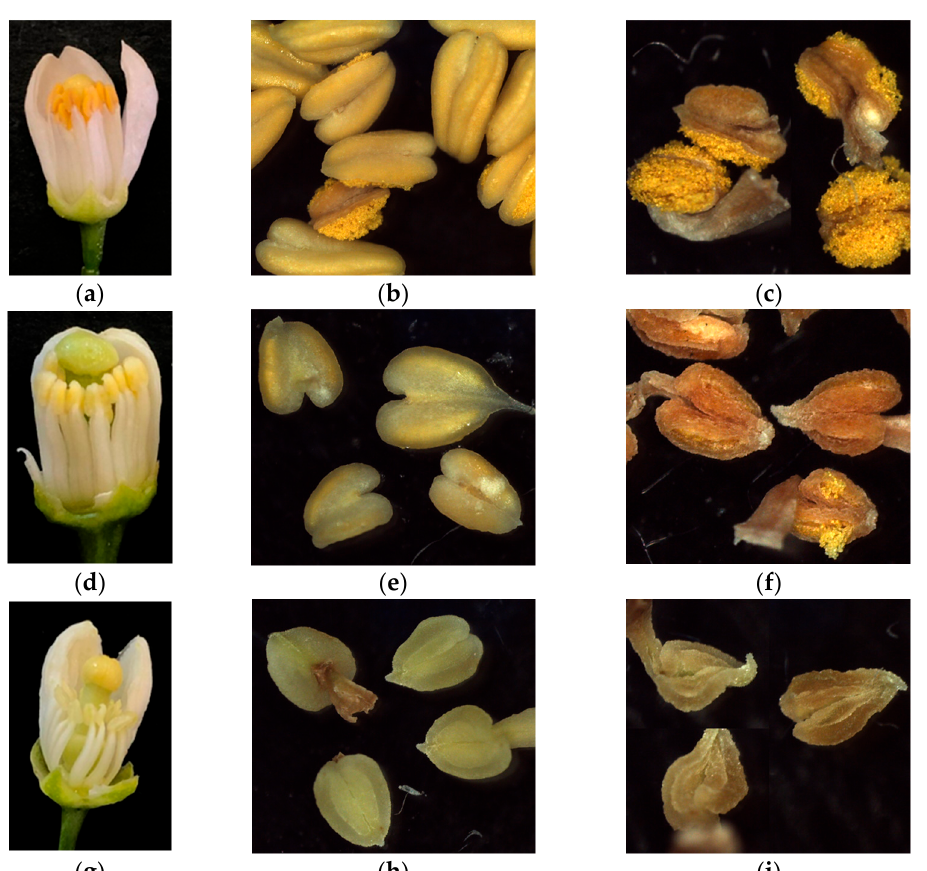
Figure 4. Di ff erent types of fl ower phenotypes observed in the segregation progeny recovered from Figure 4. Different types of flower phenotypes observed in the segregation progeny recovered from the cross between ‘Kiyomi’ and ‘Murco tt ’. ( a – c ) High number; ( d – f ) moderate-to-low; ( g – i ) very the cross between ‘Kiyomi’ and ‘Murcott’. ( a – c ) High number; ( d – f ) moderate-to-low; ( g – i ) very low-to-null pollen grain quantity. This quanti fi cation was observed in fl owers at anthesis ( a , d , g ), low-to-null pollen grain quantity. This quantification was observed in flowers at anthesis ( a , d , g ), fresh anthers ( b , e , h ), and dehiscent anthers ( c , f,i ). fresh anthers ( b , e , h ), and dehiscent anthers ( c , f , i ).